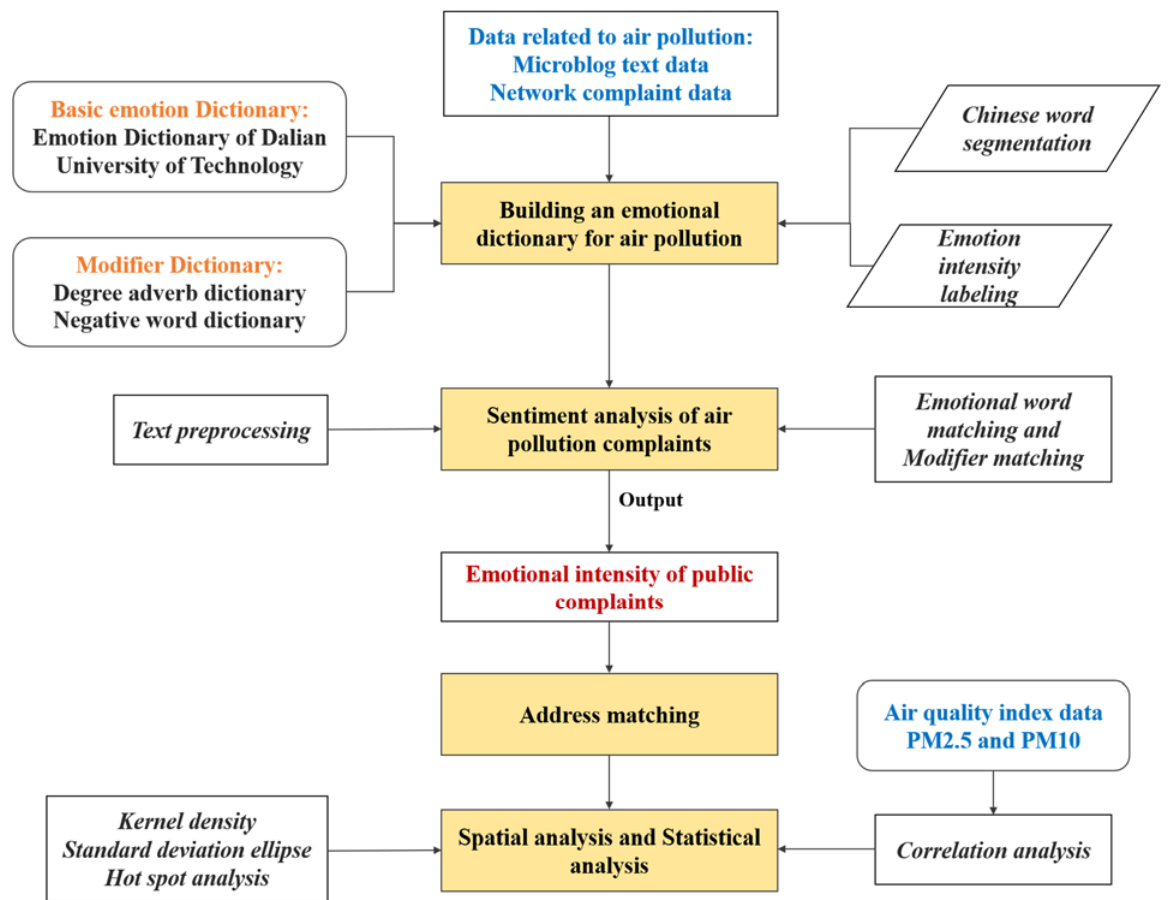
Figure 1. Flow chart of the research methods for public response to air pollution based on online complaint data and sentiment analysis.